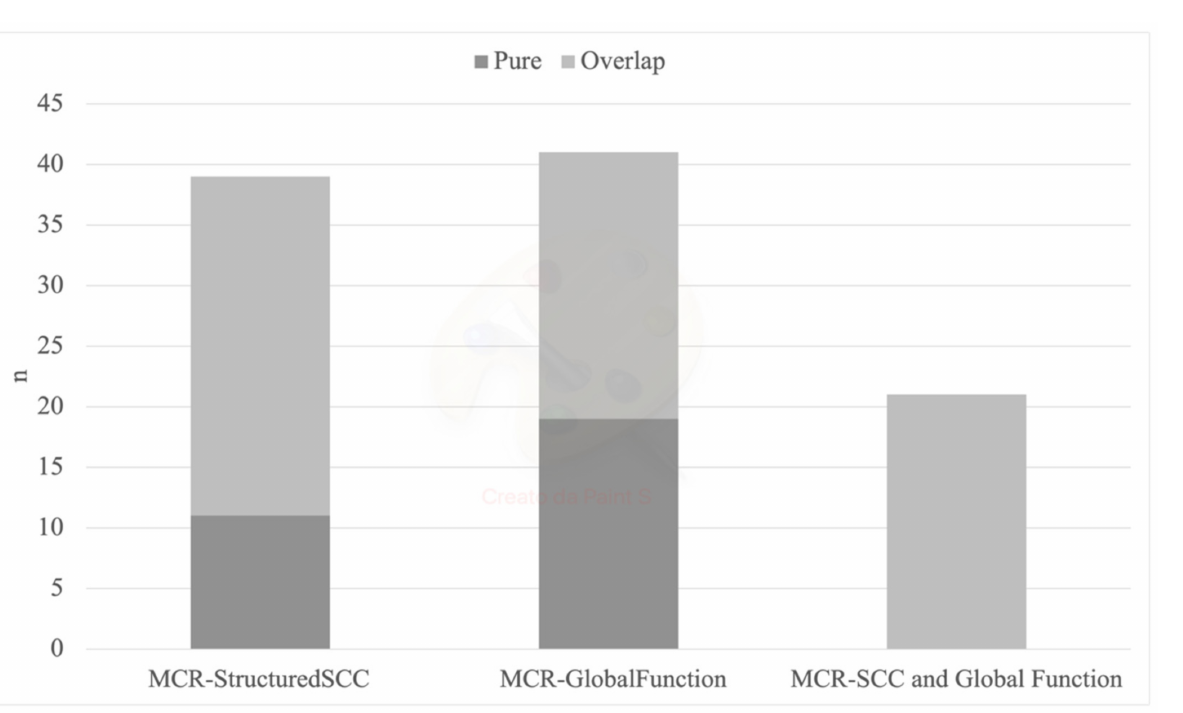
Figure 1. Overlap between MCR